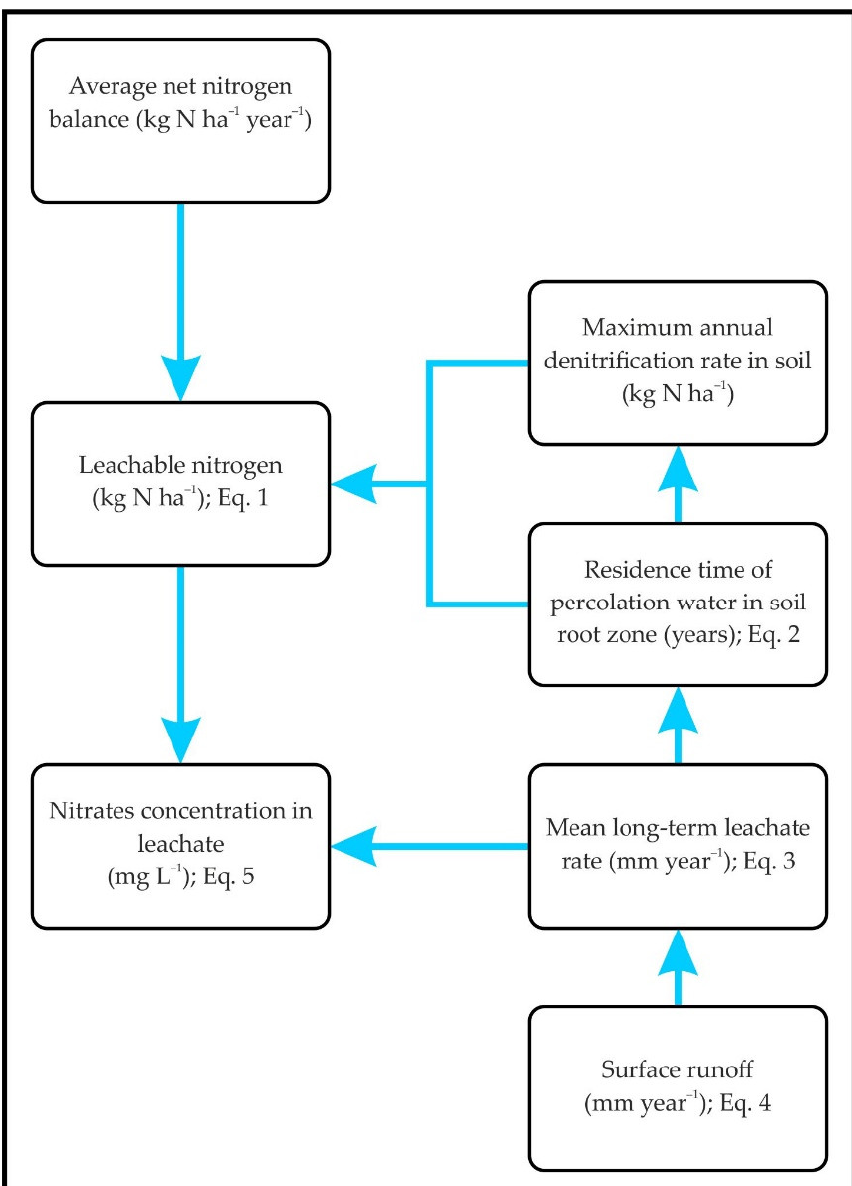
Figure 3. Summary flowchart for calculation of nitrate concentration in the leachate.